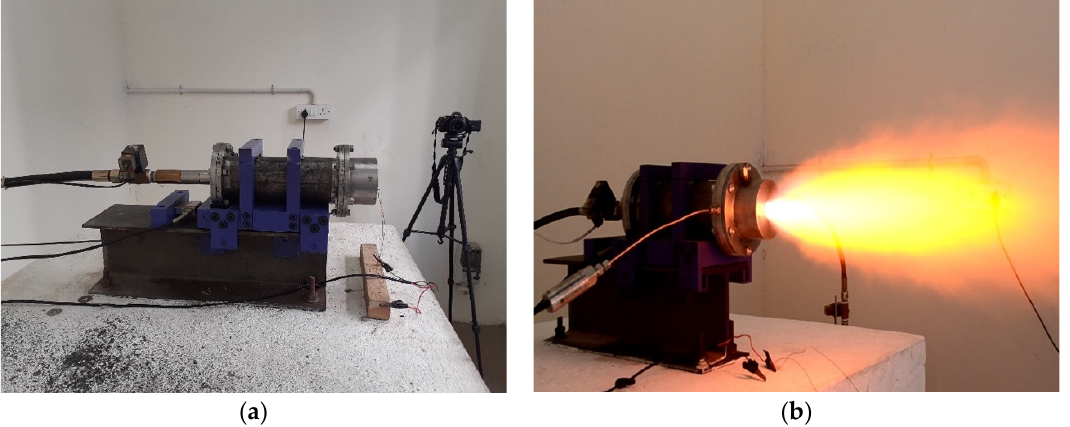
Figure 5. Photographs of ( a ) hybrid rocket mounted on the thrust stand and ( b ) motor during the ballistic test.